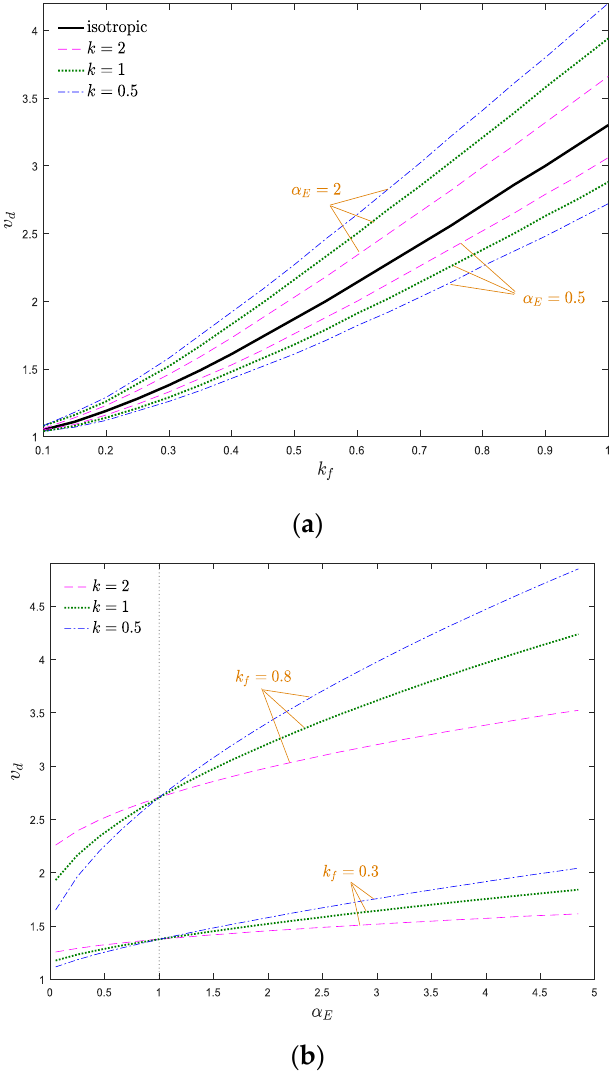
Figure 7. Dimensionless critical velocity of the system against ( a ) dimensionless flexural stiffness and ( b ) elastic modulus gradient parameter for ζ = 0, α ρ = 1, µ = 0.